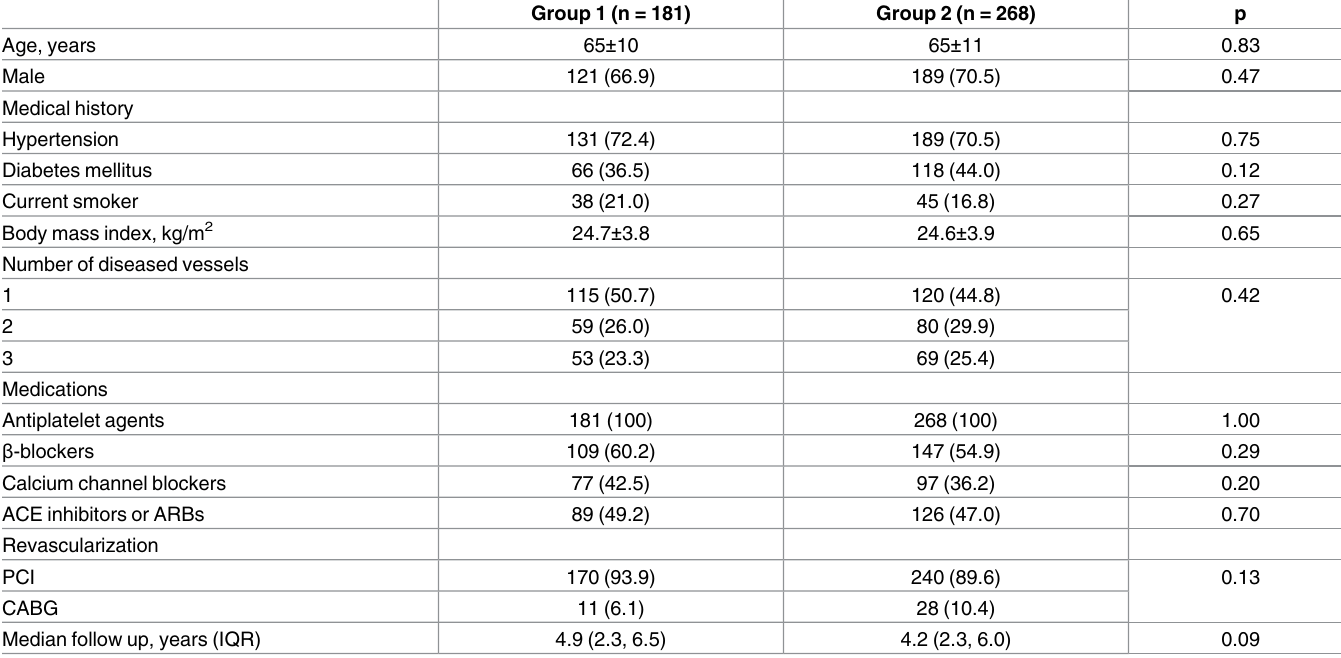
Table 1. Baseline characteristics of the